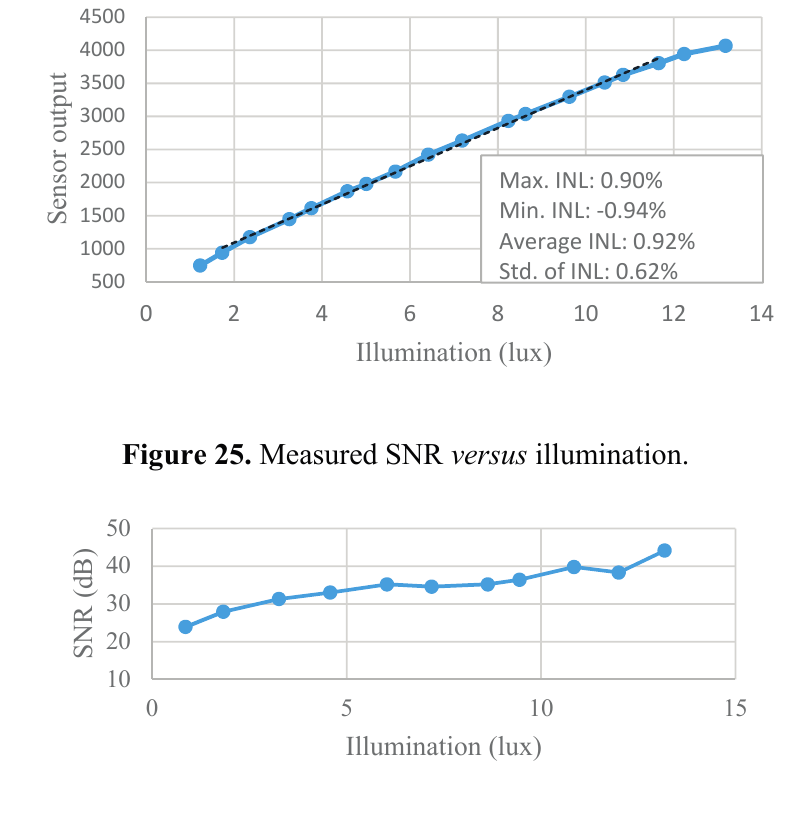
Figure 24. CIS output versus illumination and measured INL for an output range between 20% and 90% of saturation.